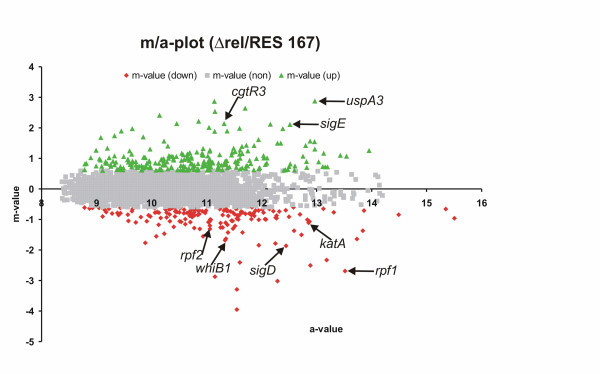
The m/a scatter plot comparing the transcriptomes of the C. glutamicum rel-deficient and the rel-proficient strains. Genes with a reduced transcription are indicated by red dots and those with an upregulated transcription by green dots. Genes described in the text and showing the strongest changes in the expression ratio are marked by arrows.